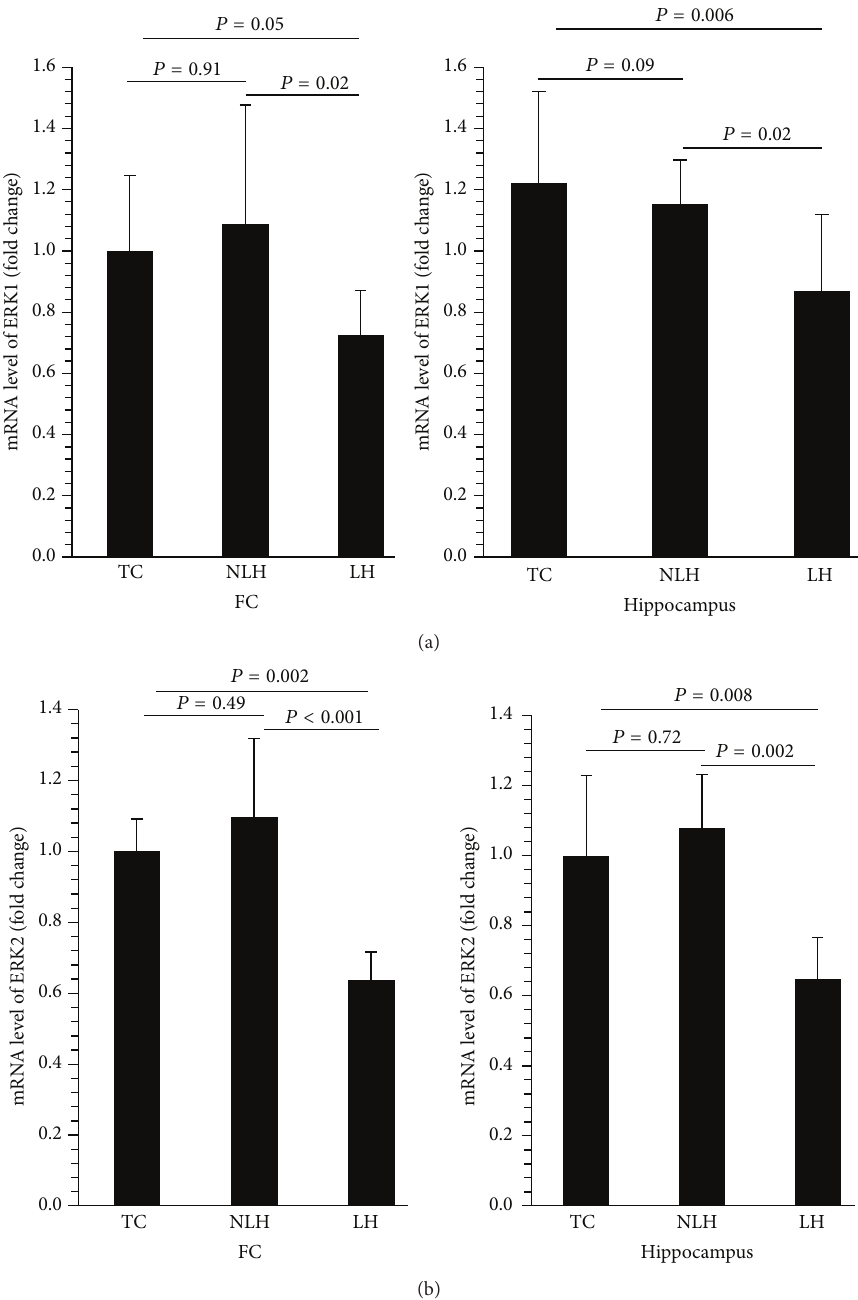
Figure 4: mRNA levels of ERK1 and ERK2 in frontal cortex (FC) (a) and hippocampus (b) of TC, non-LH, and LH rats. Data are the mean ± SD from 6 animals in each group. Overall group differences in the 3 groups are as follows. ERK1: FC, df = 2, 15 , 𝐹 = 5.17 , and 𝑃 = 0.02 ; hippocampus, df = 2,15 , 𝐹 = 7.92 , and 𝑃 = 0.004 . ERK2: FC, df = 2, 15 , 𝐹 = 16.53 , and 𝑃 < 0.001 ; hippocampus, df = 2, 15 , 𝐹 = 10.51 , and 𝑃 = 0.001